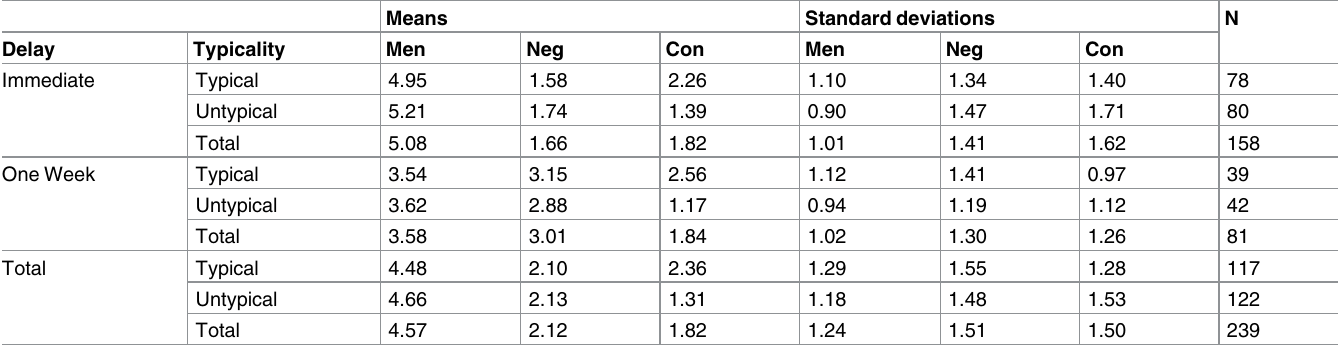
Table 1. Means and standard deviations for the ‘Present’ answers across experimental conditions—Experiment